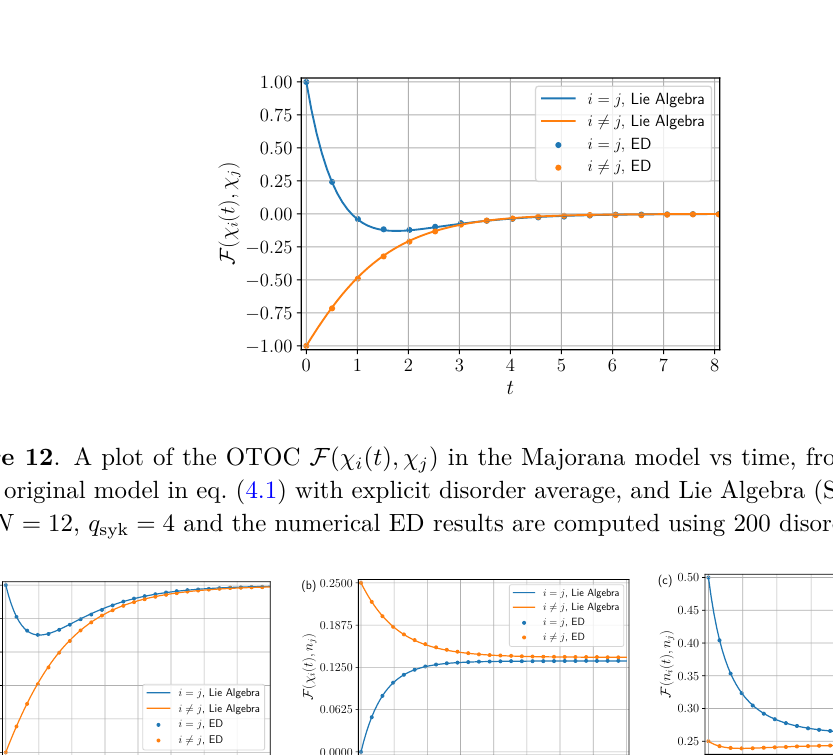
Figure 13 . A plot of the OTOCs F ( χ i ( t ) , χ † time, from both the ED of the original model in eq. (5.1) and Lie Algebra (SU(4)) methods. Here N = 6 , q syk = 4 and the numerical ED results are computed using 500 disorder